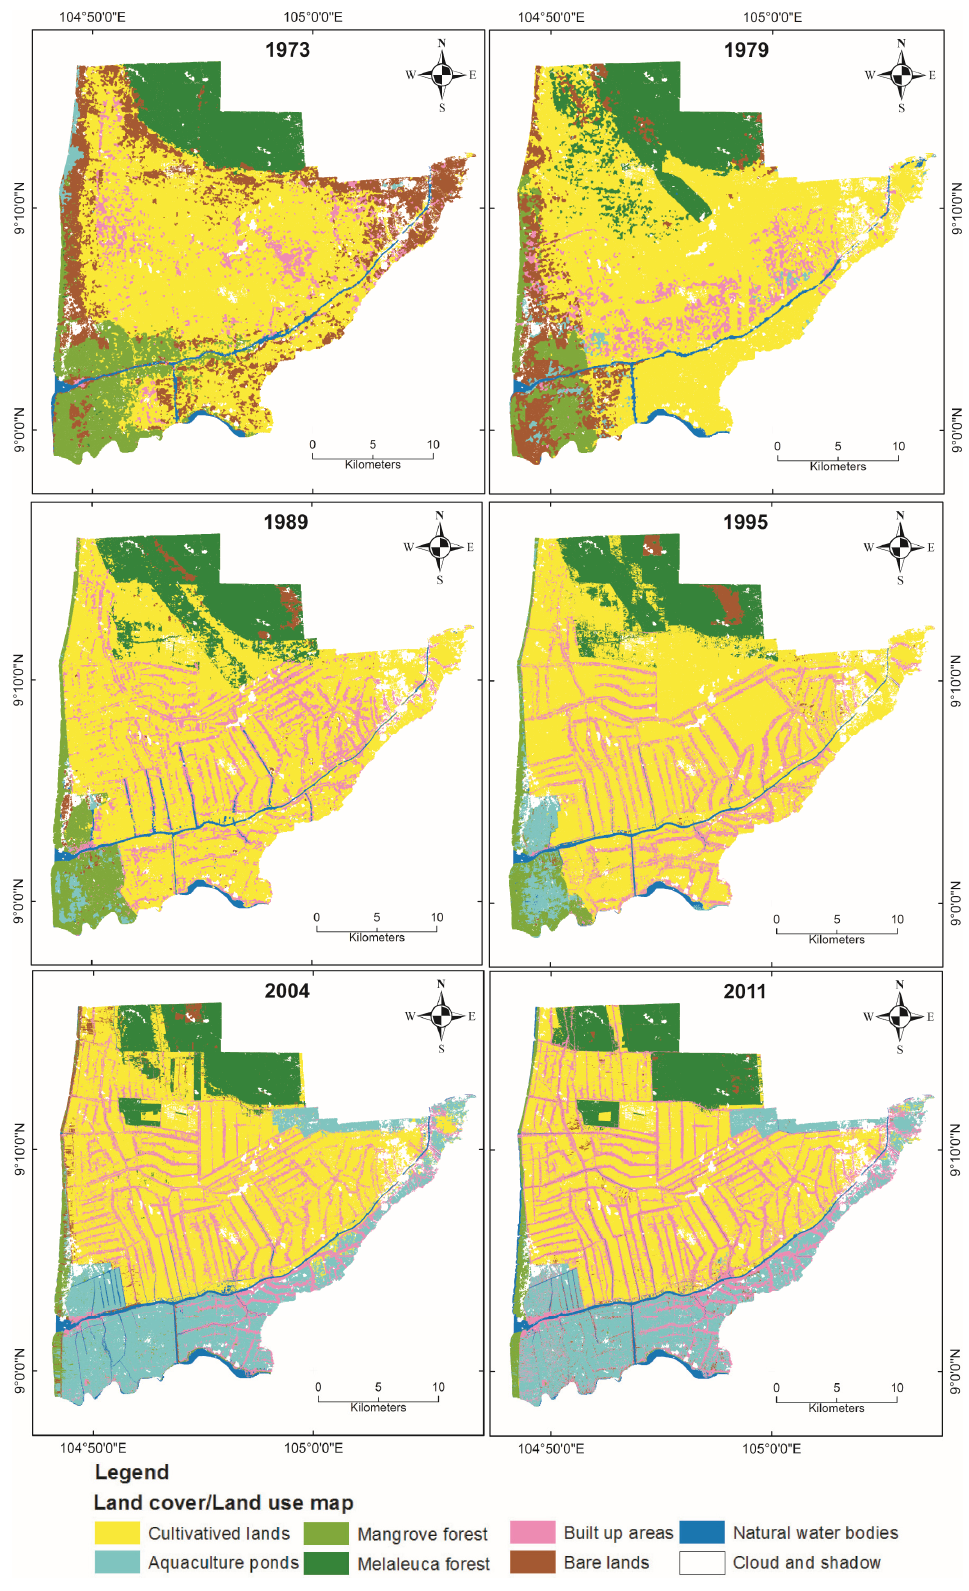
Figure 6. Land cover/land use classification maps of the Tran Van Thoi District in year 1973, 1979, 1989, 1995, 2004 and 2011 based on supervised spectral classification of Landsat MSS (1973, 1979), Landsat TM (1989), SPOT3 (1995), and SPOT5 (2004, 2011)